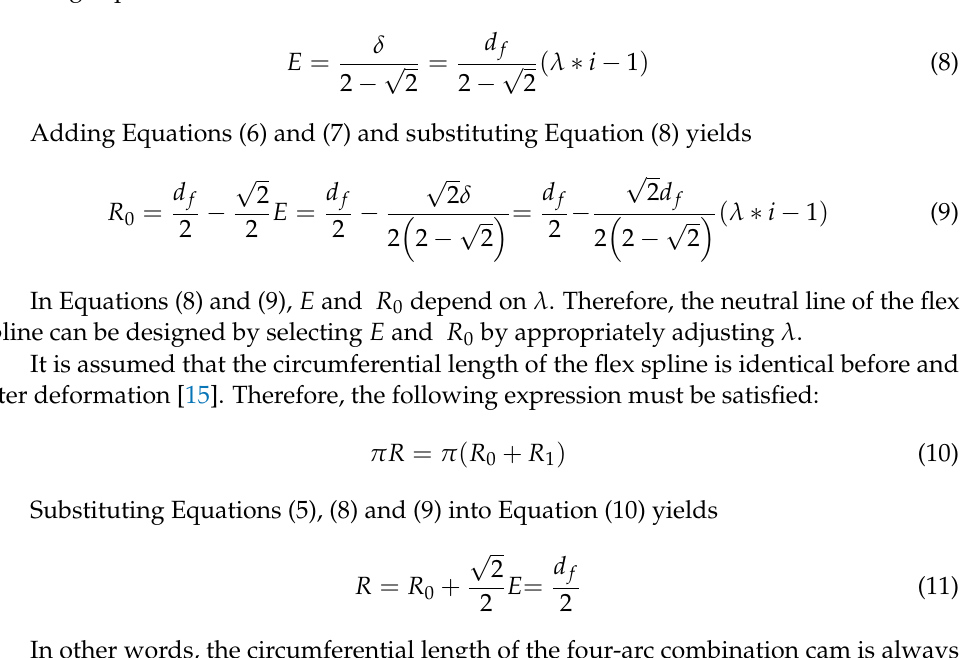
Figure 2. Sinusoidal harmonic cam curve.